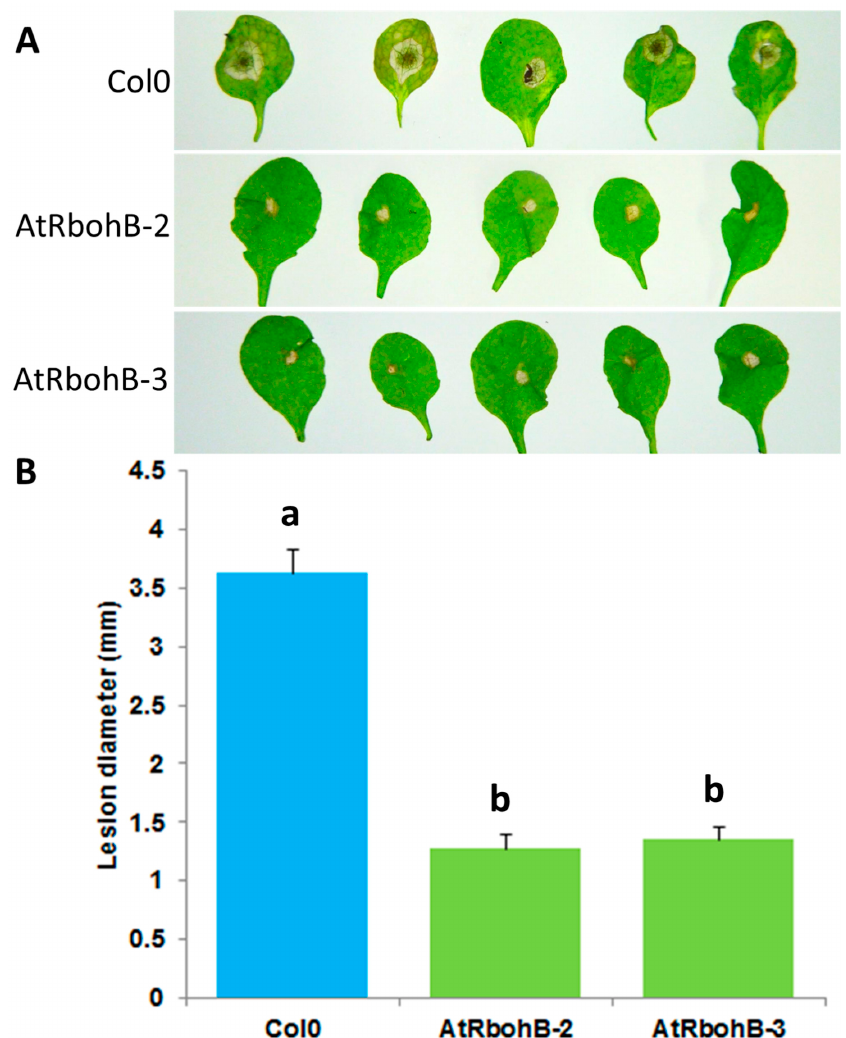
Figure 7. Functional analysis of RbohB overexpression lines in response to B. cinerea infection. A. B. cinerea infection test to evaluate the involvement of RbohB in plant defense. Overexpression lines of RbohB were compared with wild type plant after infection. Plants were infected with B. cinerea by putting a 5 μ L drop on the surface of 4-week-old leaves. Plants were grown in short day conditions with 16 h dark and 8 h light at 24 °C. Representative pictures were taken at 5 dpi. B: Lesion diameter in mm was determined at 5 dpi. For each line in a replicate, three plants were infected. Mean data from three experimental replications were subjected to analysis of variance and differences among mean determined by LSD at 5 % significance level and n = 15 with different letters “a” and “b” indicating significant difference. Values are means ± SE.